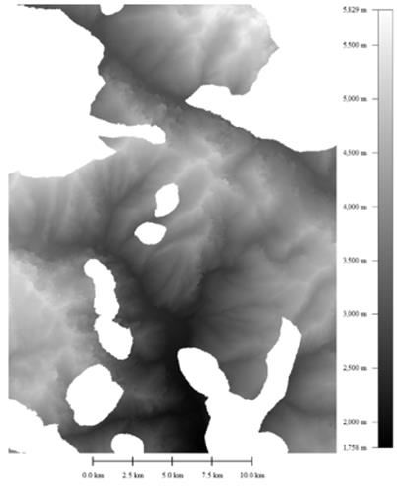
Figure 3: SRTM X band DEM of the Study